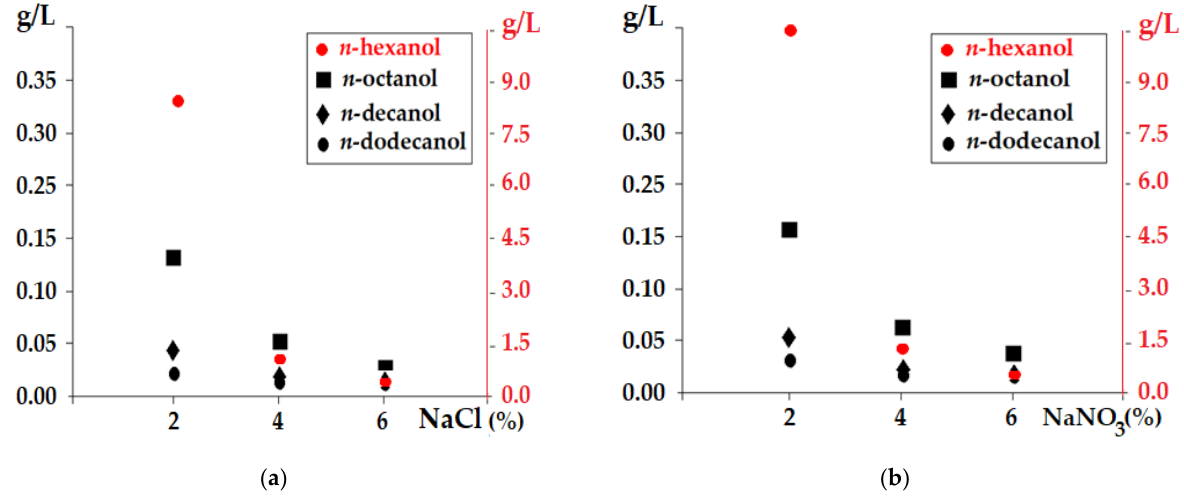
Membranes 2022 , 12 , x FOR PEER REVIEW Figure 4. Materials’ loss from the dispersion bulk liquid membrane: ( a ) HCl acid source phase; ( b ) HNO 3 acid source phase as a function of the weight concentration of the considered salts.